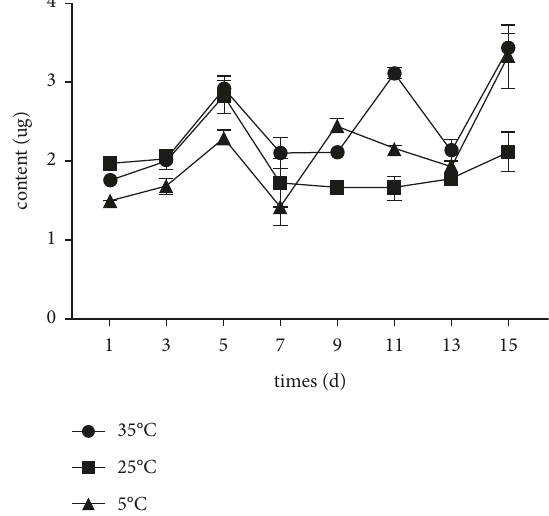
Figure 7: The content change curve at different temperatures of